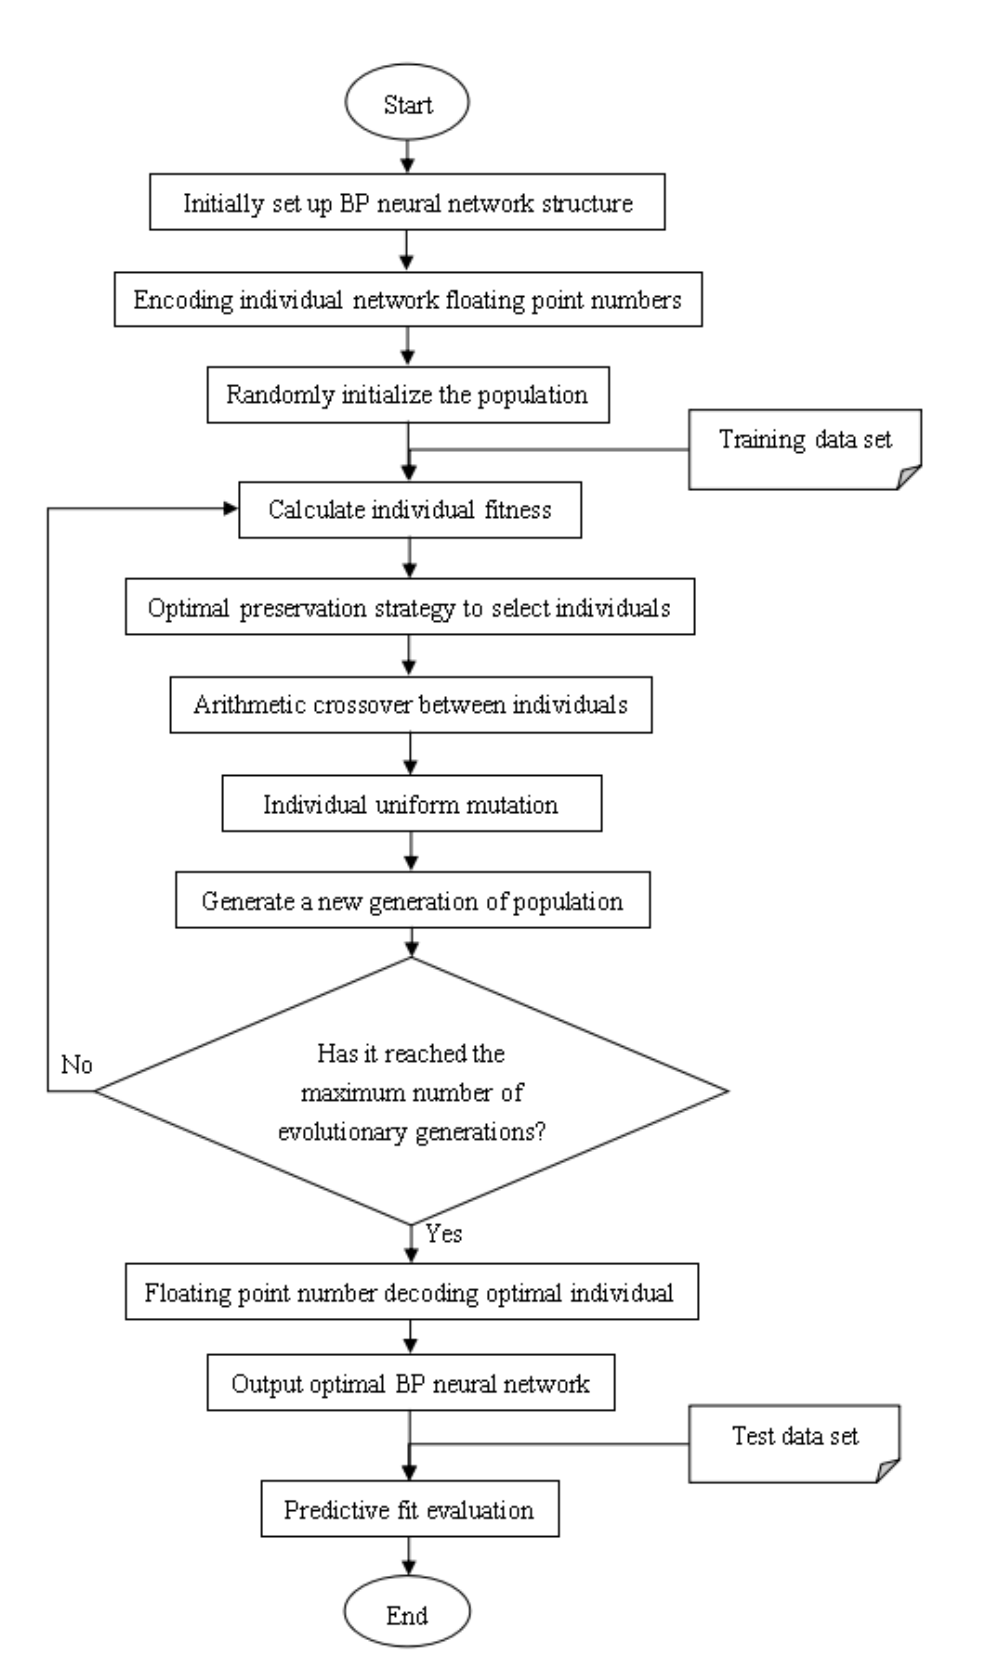
Figure 8. Flow chart of GA-BP HFMD epidemic prediction